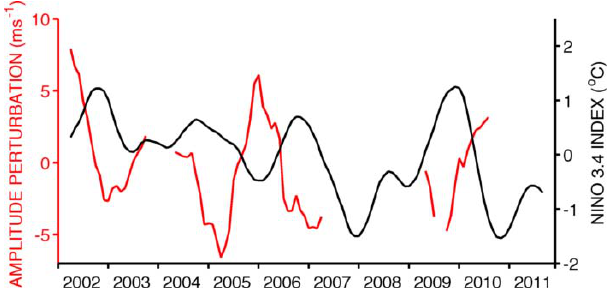
Fig. 17. Perturbations in meridional diurnal tide amplitudes (calcu- lated by subtracting the composite-year monthly mean from each individual month) at heights near 84km (red line) for 2002–2011 over Ascension Island. Also plotted are the data from the Niño 3.4 index (black line), representing sea surface temperature perturba- tions in the Niño 3.4 Pacific Ocean region. The diurnal tidal ampli- tude perturbations and Niño 3.4 index are smoothed with a seven- month running mean. Note the two different axes, with the red axis on the left corresponding to the diurnal amplitude perturbations and the black axis on the right corresponding to the Niño 3.4